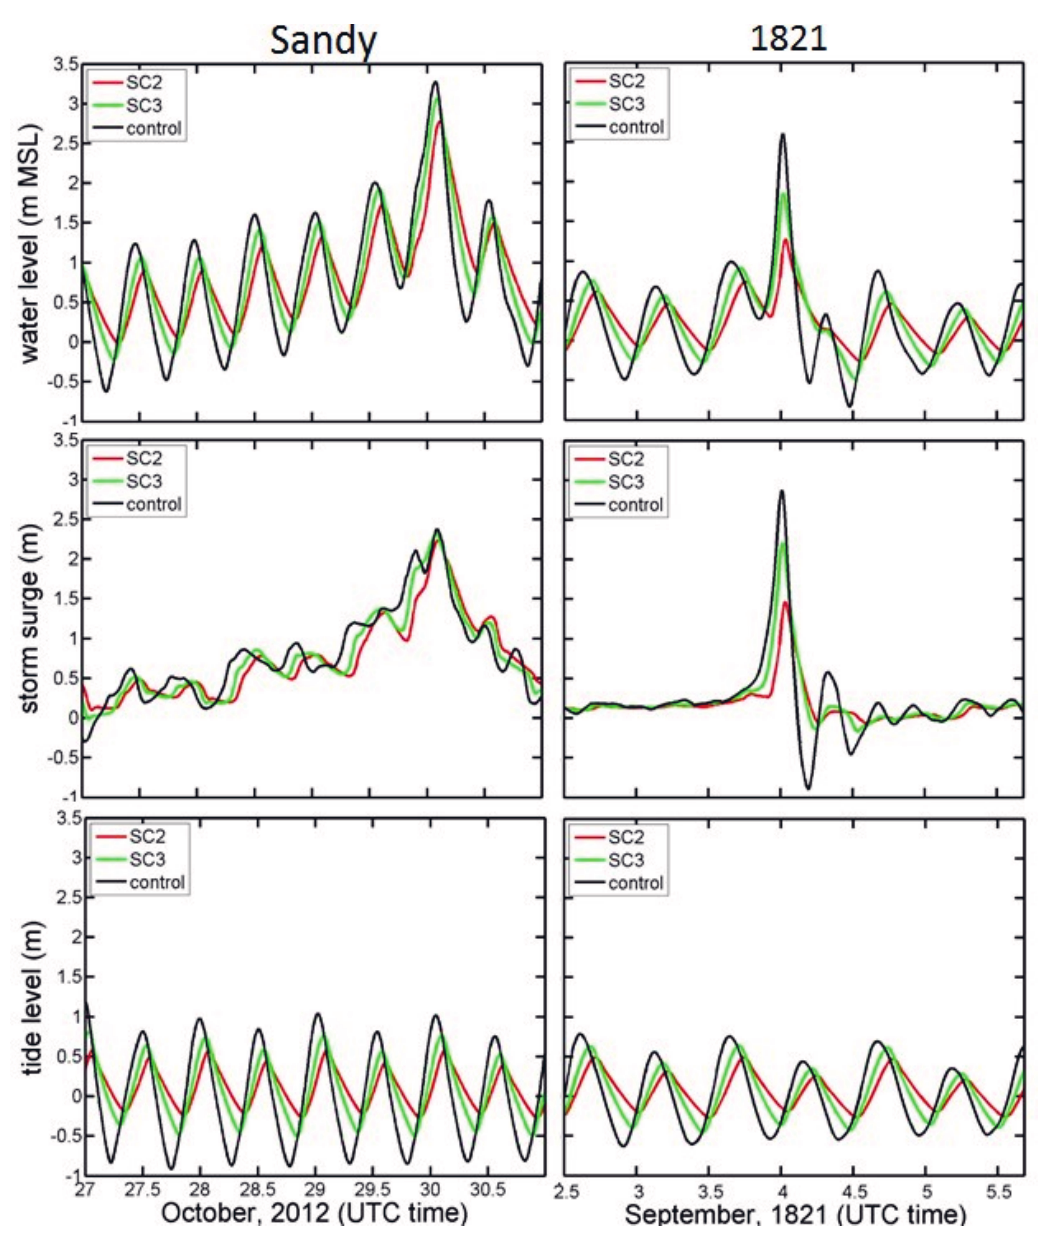
Figure 9. Time series of ( top ) water level, ( middle ) surge, and ( bottom ) tide level at JBI for Sandy ( left ) and the 1821 Hurricane ( right ), for the control runs and two shallowing